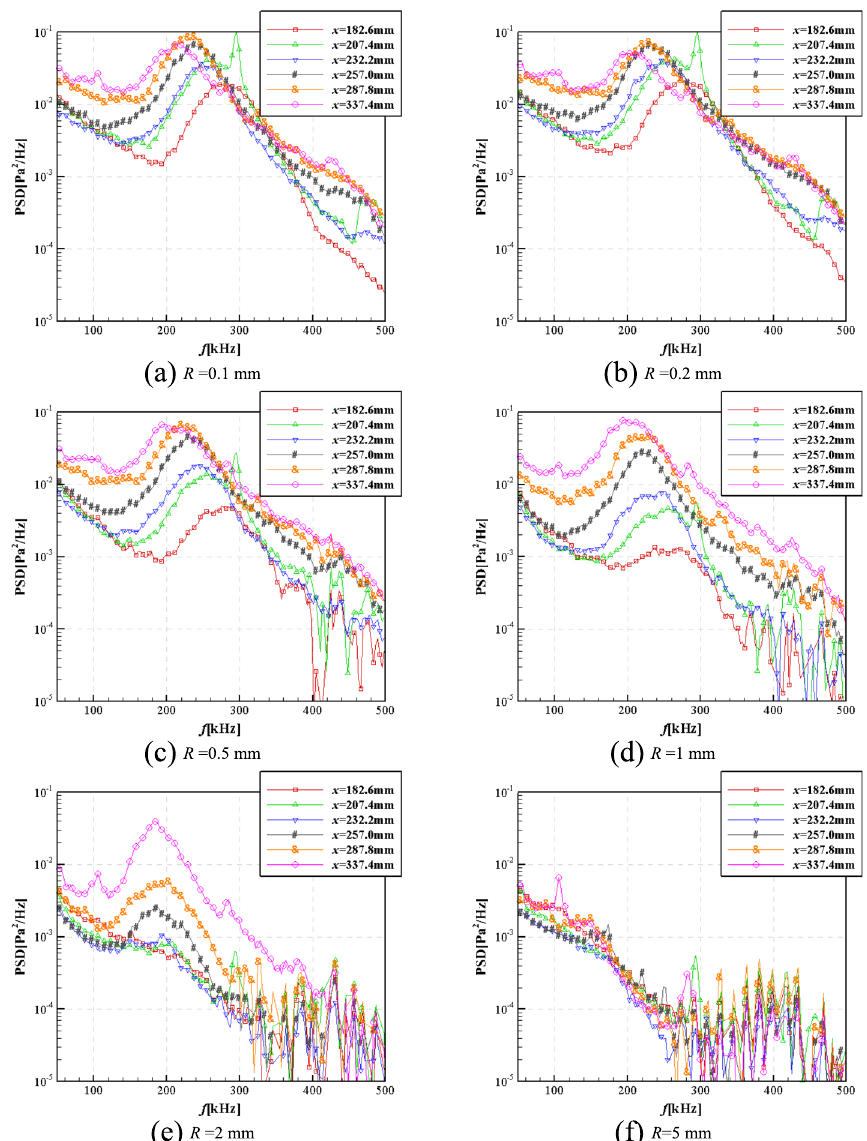
Fig. 10 PSD of wall pressure fluctuations at different cone bluntness. The wall temperature of the cone model is 300 K, the stagnation pressure of the wind tunnel is 6E 5 Pa, the stagnation temperature of + the wind tunnel is 454 K, and the corresponding Reynolds number is 6E 6/m + Table 2 Cross-correlation of the first four PCB sensors, Re 6E 6/m unit = + NO. 1 NO. 2 NO. 2 NO. 3 NO. 3 NO. 4 NO. 4 NO. 5 → → → → Δ x (mm) 25 25 25 30 Δ t (μs) 32.3 33.3 32.7 40.3 U/U e 0.87